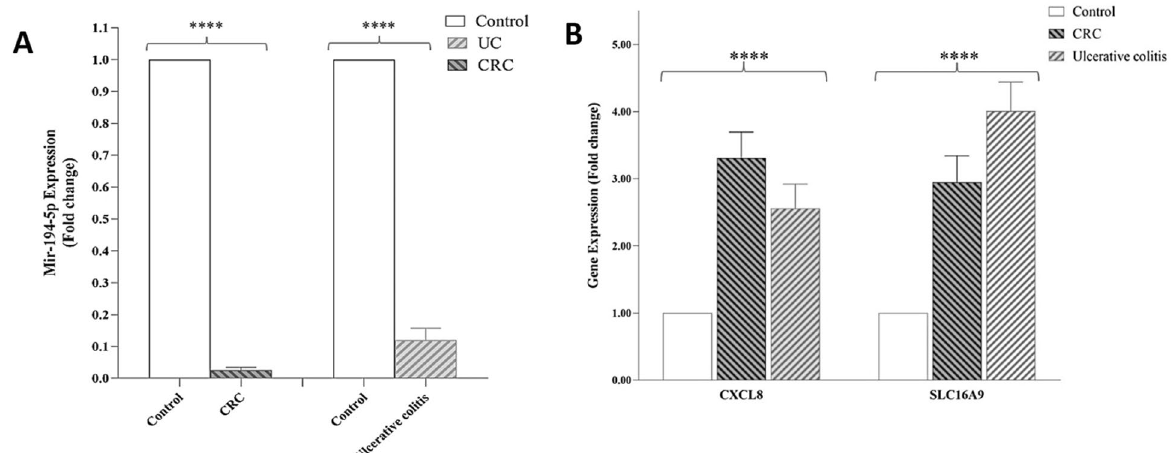
Figure14. Comparison of biomarker expression based on fold change in CRC, UC, and normal samples. ( A ) miR-194-5p expression, ( B ) CXCL8 and SLCA16A9 gene expression. * P < 0/05, ** P < 0/01, *** P < 0/001, **** P < 0/0001, CRC: Colorectal Cancer Cell, Control: Normal tissue, UC: Ulcerative